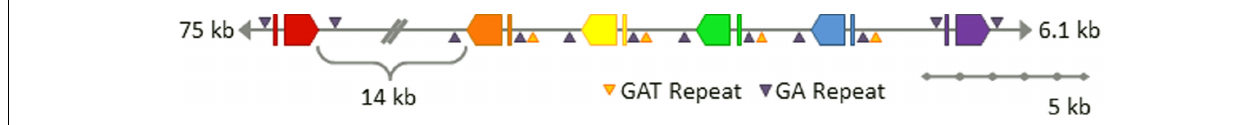
patterns). All are located near the 3 (cid:2) end of the BAC insert. Gene orientations are indicated and spacing is to scale unless otherwise noted. GA microsatellites flank each gene and GAT microsatellites flank segmental duplications that are positioned on 5 (cid:2) side of B8 and include the three D1 genes.This is Figure 4 from Miller et al. (2010) reproduced with permission from BioMed